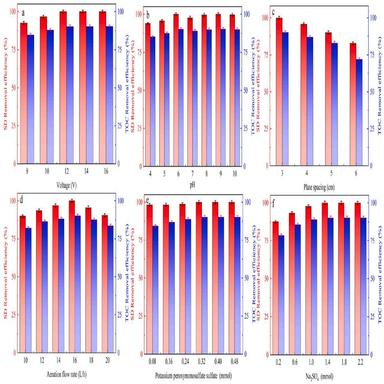
Effects of voltage (a), pH (b), plate spacing (c), aeration flow rate (d), potassium peroxymonosulfate sulfate complex salt (e), Na2SO4 dosage (f) on degradation.